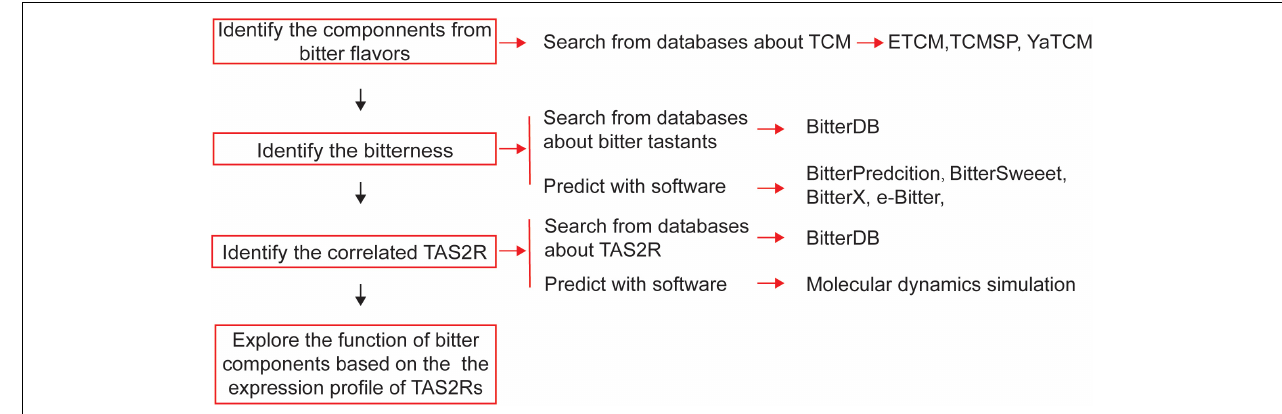
FIGURE 4 | Schematic diagram of the process of bioinformatics-aided in silico analysis of bitter flavored TCM from databanks in order to develop novel drugs for regulating muscle relaxation/contractility.